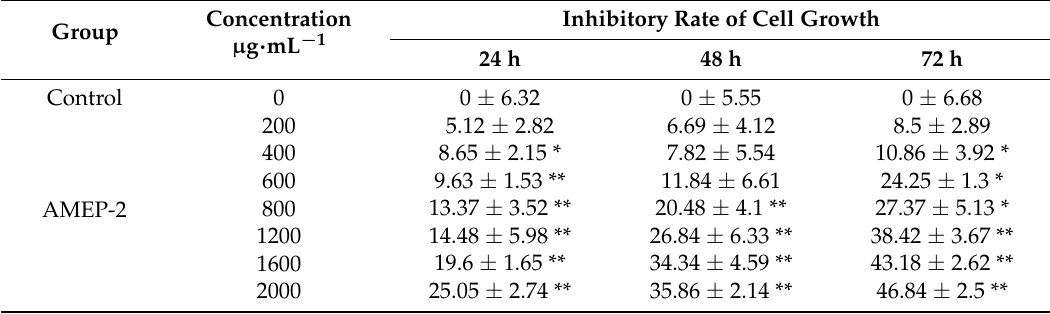
Table 2. Cytotoxic effects of AMEP-2 on BGC-823 cells ( x ± s, n = 6, %, * p < 0.05 vs. control, ** p < 0.01 vs.